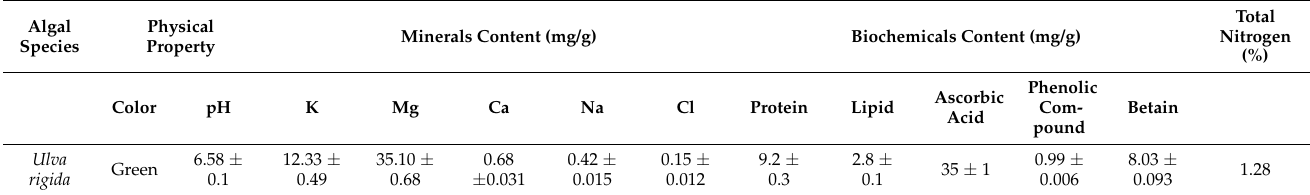
Table 1. Physical, biochemical, and mineral constituents of seaweed ( Ulva rigida )